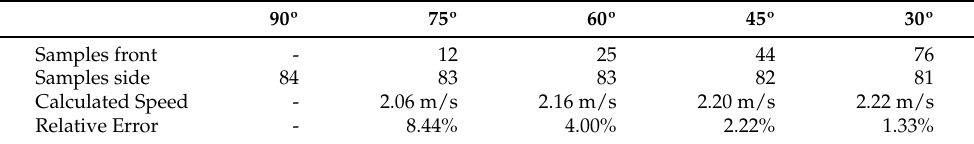
Table 1. Simulation data obtained. Average of the valid samples in the detection of the front and side of the vehicle and calculated speed, together with the corresponding errors.